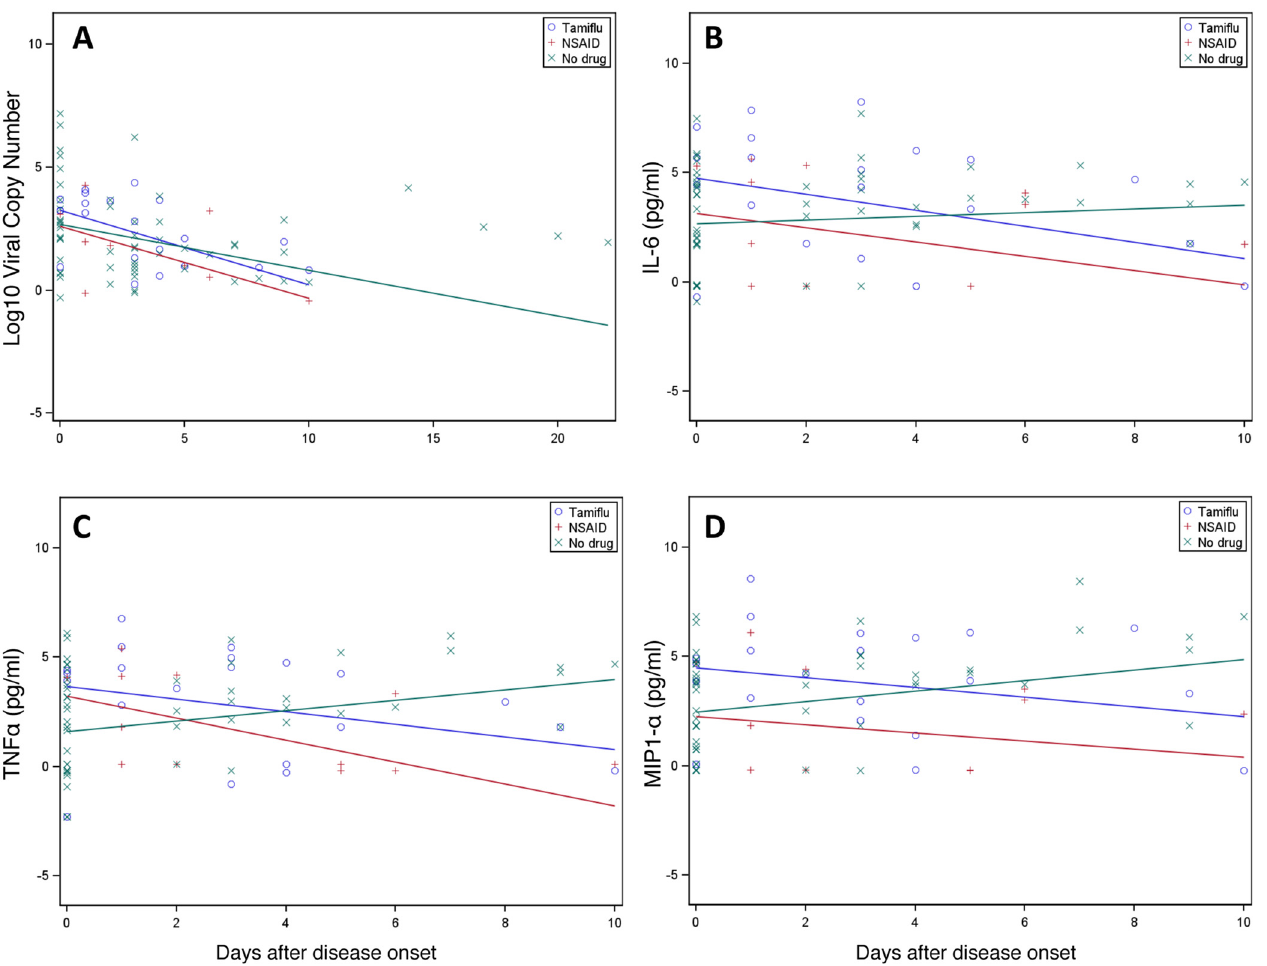
Fig 3. Oseltamivir therapy in longitudinal human samples. (A) Viral loads from nasal swabs and (B-D) natural log-transformed cytokine concentrations from nasal lavages of patients infected with influenza viruses over the course of the 2009 – 2012 influenza seasons were obtained by (A) PCR or (B-D) Milliplex bead array. Observed measures were presented overlaid with coloured lines that were predicted from